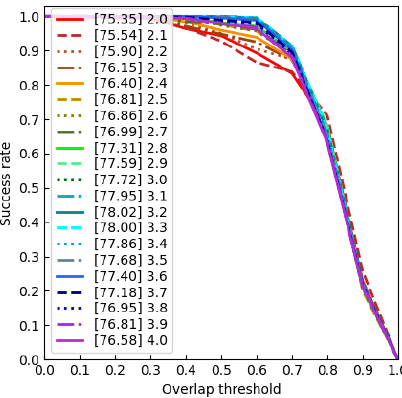
Figure 10. Success plot for per threshold and the legend is the AUC per threshold.